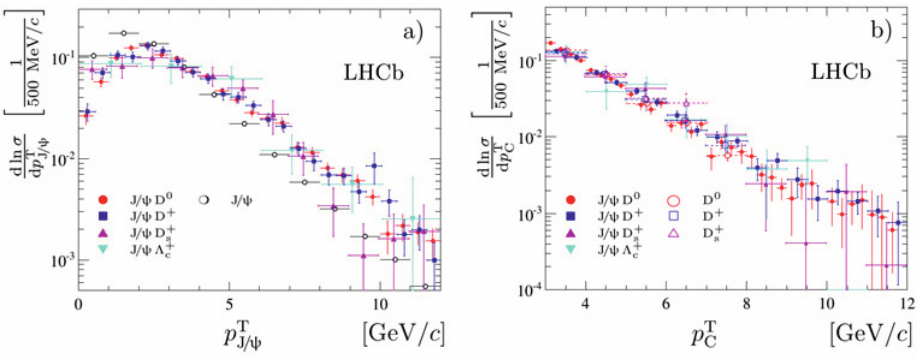
Figure 18. a) Transverse momentum spectra of J /ψ for J /ψ C and prompt J /ψ events. b) Transverse momentum spectra for open charm hadrons for J /ψ C and prompt D 0 , D + and D + s events.